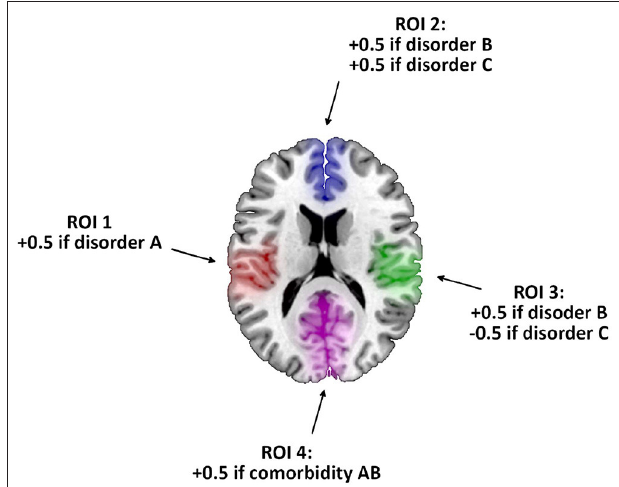
FIGURE 1 | Rules for creating the gray matter maps of a simulated patient. After creating a map using white noise, we added or subtracted 0.5 in the colored brain regions of interest (ROI) depending on the disorders he/she